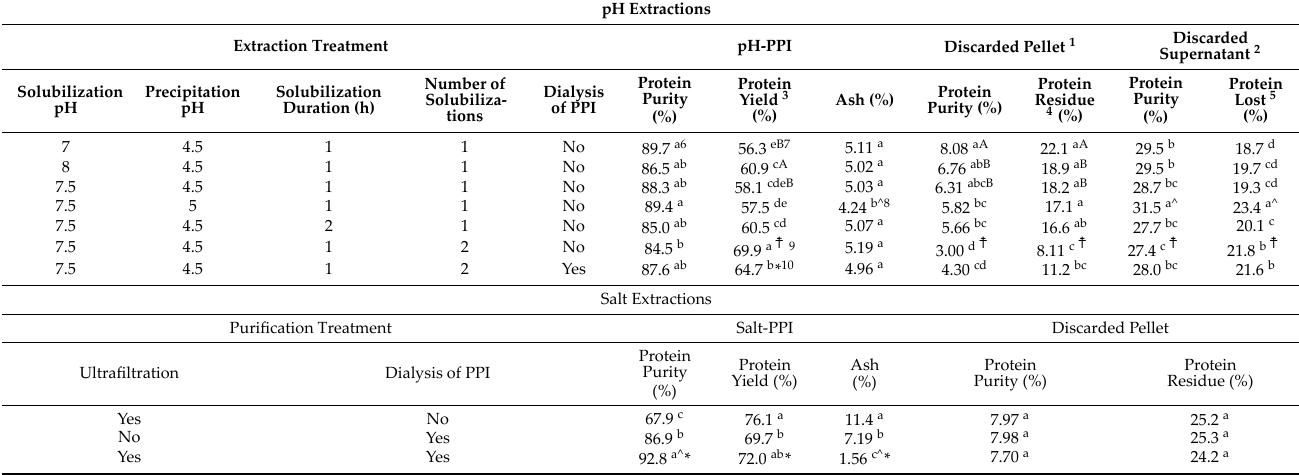
1 Pellet discarded after alkaline or salt solubilization; 2 Supernatant discarded after isoelectric precipitation; 3 Protein yield (%) represents the amount of protein extracted relative to the total amount of protein in the starting pea flour; 4 Protein residue (%) represents the amount of protein left in the discarded pellet relative to the total amount of protein in the starting pea flour; 5 Protein lost (%) represents the amount of protein lost to the discarded supernatant relative to the total amount of protein in the starting pea flour during pH extractions; 6 Means ( n = 3) in each column with different lowercase letters indicate significant differences across extraction treatments; 7 Means with different capital letters indicate significant differences among different solubilization pHs; means with no capital letters indicate no significant differences, according to the Tukey–Kramer multiple means comparison test ( p < 0.05 ); 8 A carrot (^) in pH extractions designates a significant difference among corresponding samples precipitated at pH 4.5 and 5, while a carrot (^) in salt extractions designates a significant difference among corresponding samples with and without ultrafiltration, as tested by the student’s two-sample unpaired t -test ( p < 0.05); 9 A cross of Lorraine ( ☨ ) designates a significant difference among corresponding samples solubilized once or twice, as tested by the student’s two-sample unpaired t -test ( p < 0.05); 10 An asterisk (*) designates a significant difference among a corresponding dialyzed and non-dialyzed sample, as tested by the student’s two-sample unpaired t-test ( p < 0.05).